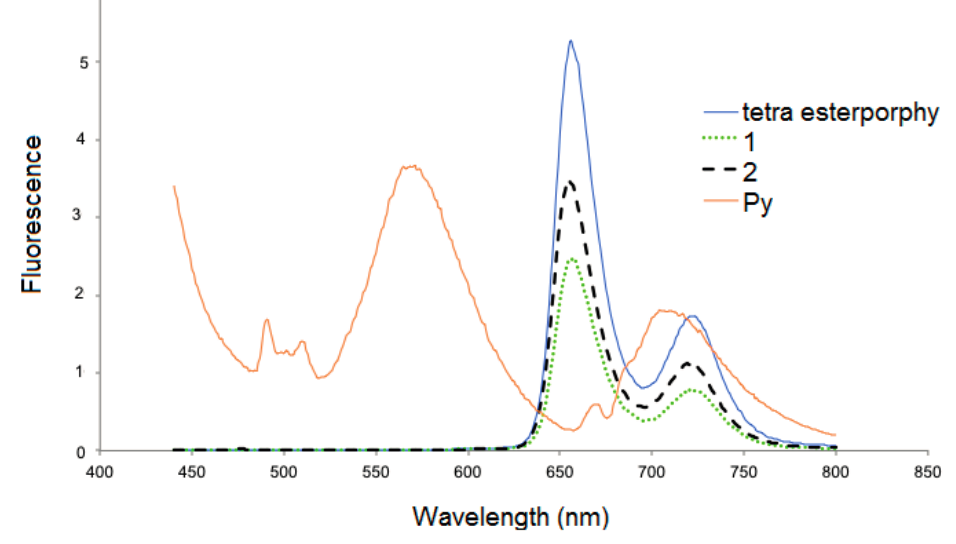
Figure 3. Fluorescence spectra of 1-pyrenecarboxaldehyde tetra esterporphyrin and dendrimers 1 , 2 in CH 2 Cl 2 at room temperature at the concentration of 3.0 × 10 − 6 M.